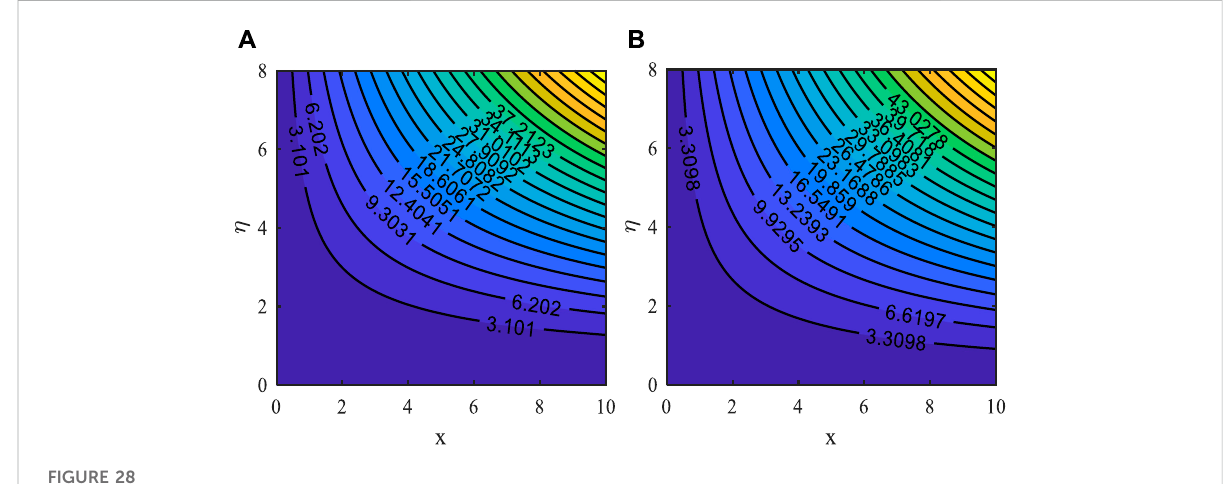
FIGURE 28 Streamline patterns for different values of λ (A) λ (cid:2) 0 (B) λ (cid:2) 0 .